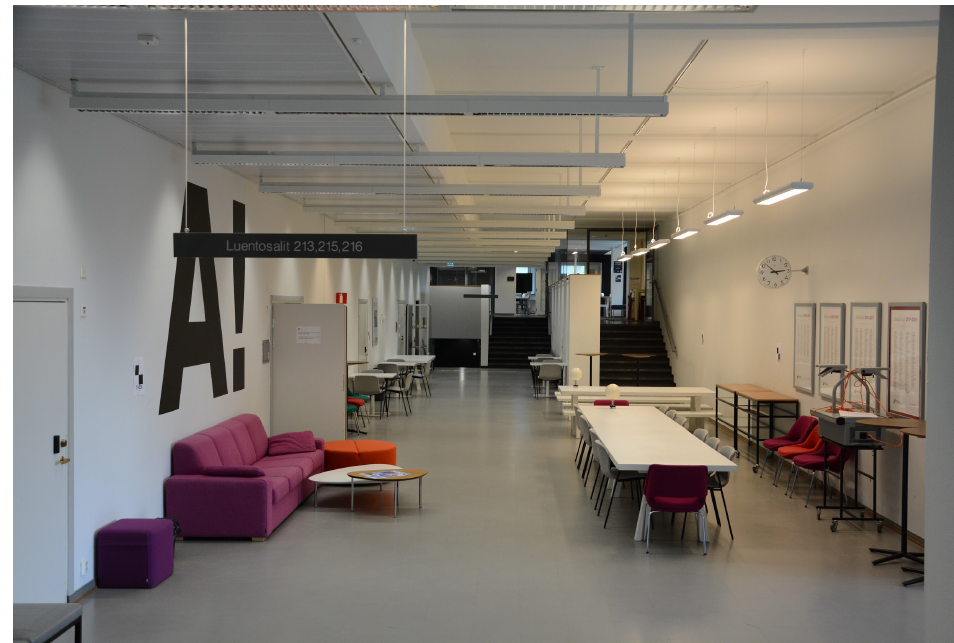
Figure 3. The hallway on the second floor.